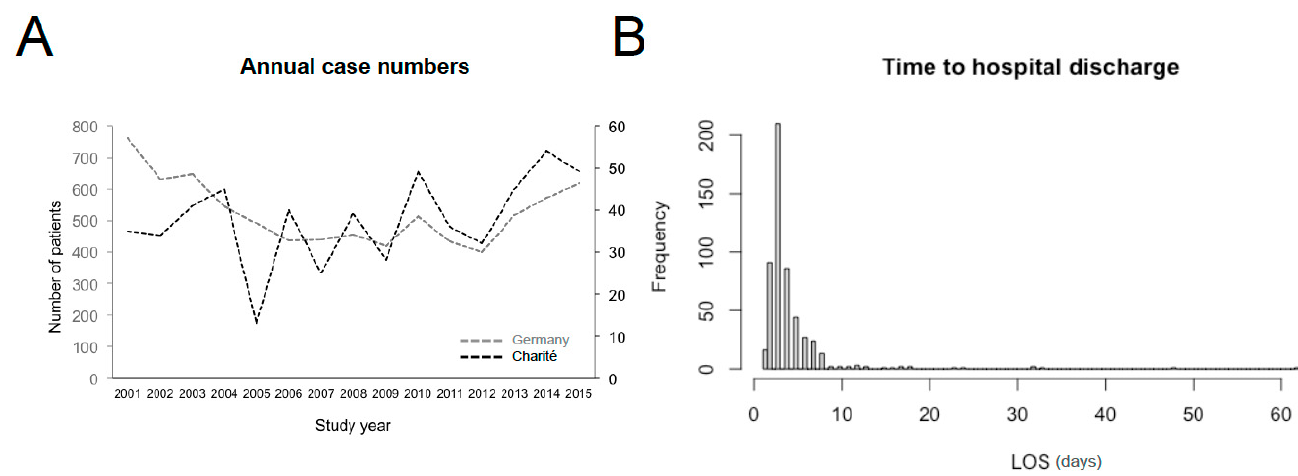
Figure 2. The 535 cases included in the study represented 7.1% of the total 7866 imported falciparum malaria cases notified in Germany during the study period ( A ). Note the different scales for total German cases (light grey) and cases treated in the study site (black). ( B ) Length of hospital stay in the study population.